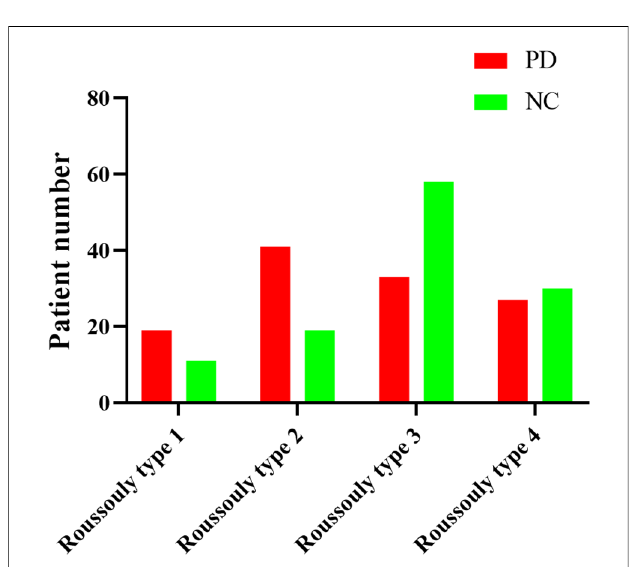
FIGURE 4 The patients number of PD group and normal group in each Roussouly spine classi fi cation type.